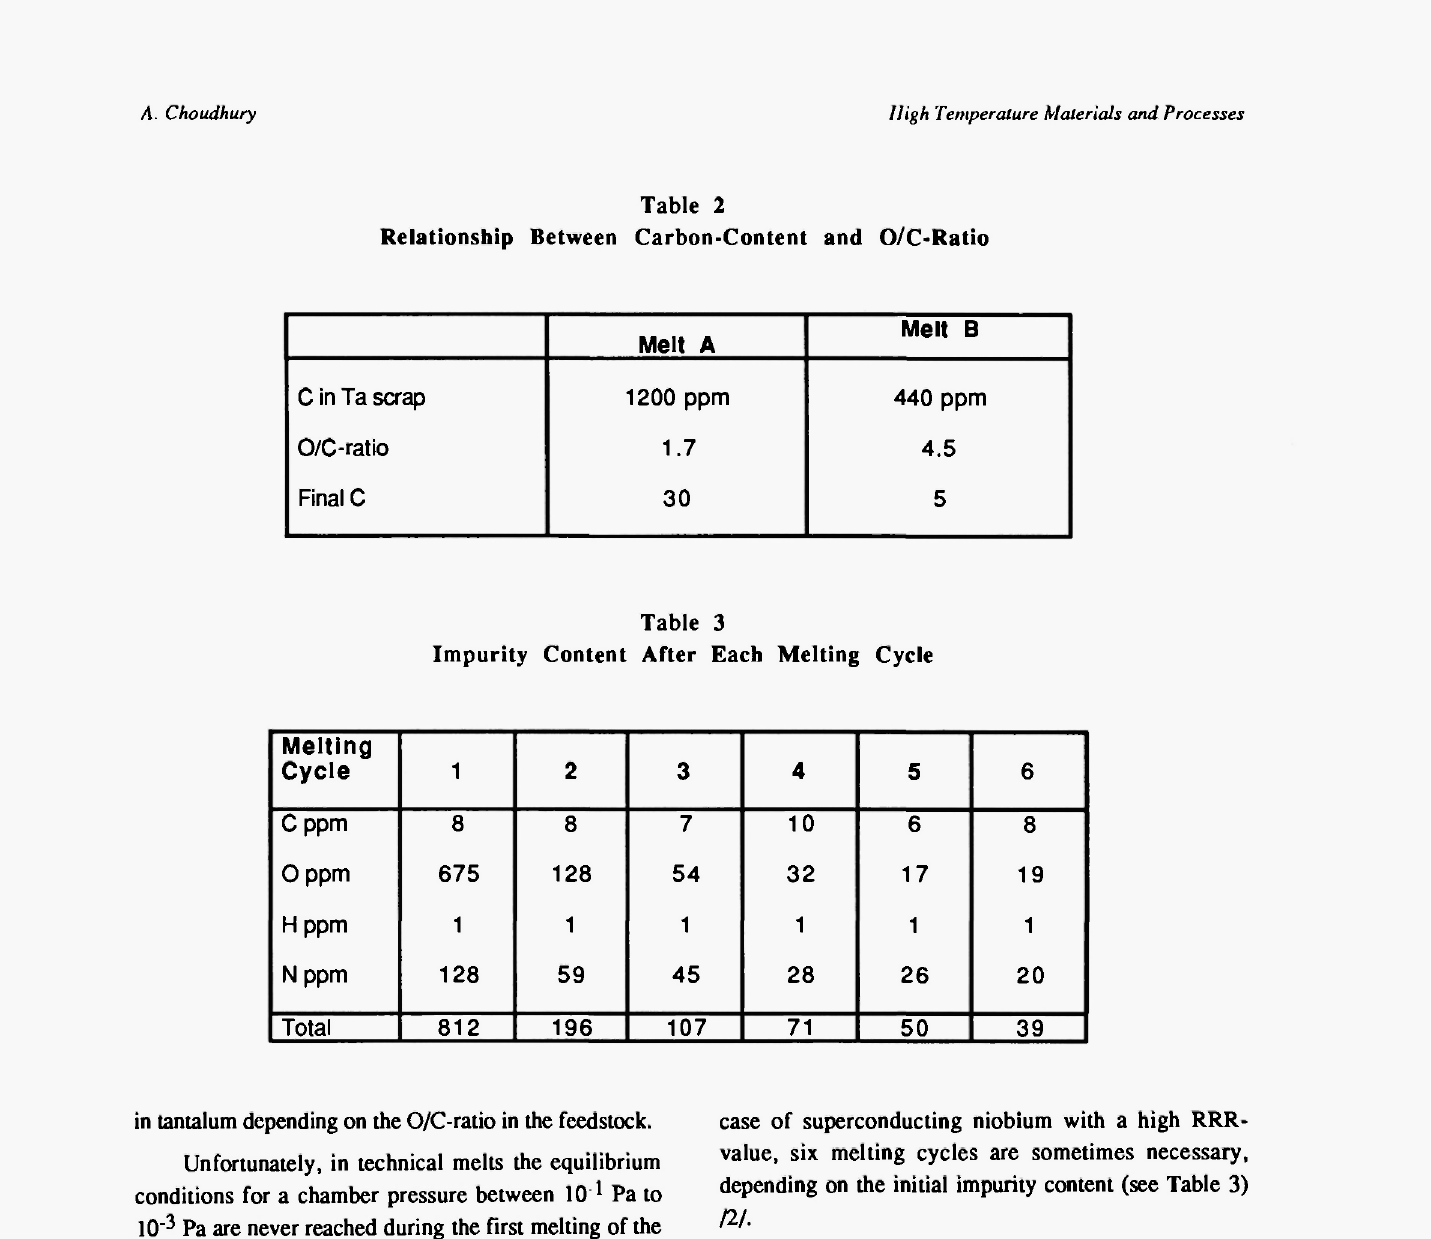
Impurity Content After Each Melting